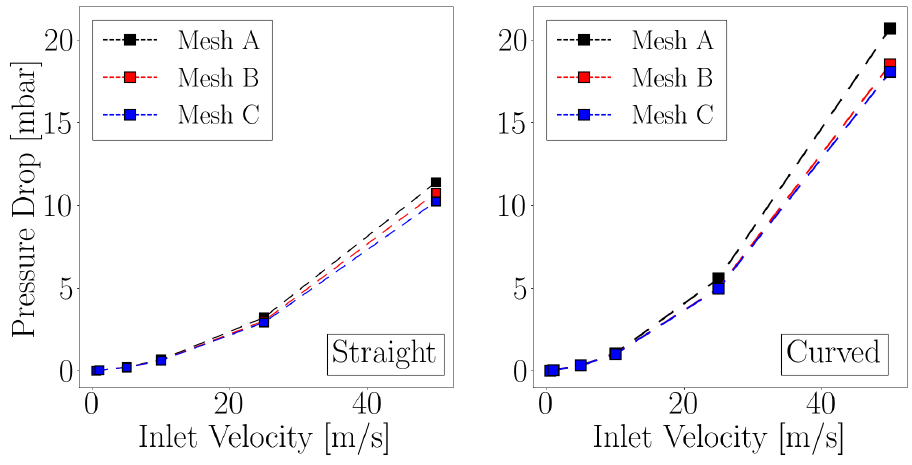
Figure 8. Assessment of the POCS pressure drop: straight and curved POCS